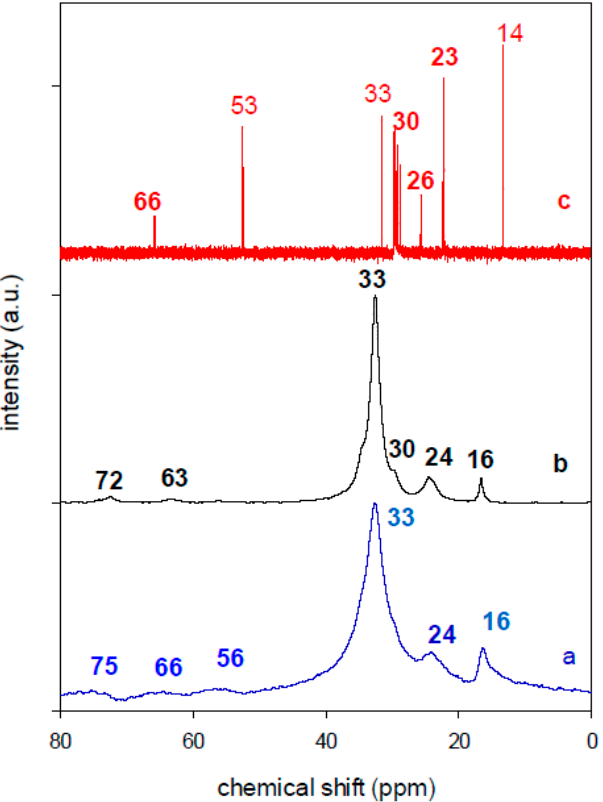
Figure 6. Solid 13 C-CP-NMR of the ( a ) organoclay C 16 Cl-CN, ( b ) the C 16 Br solid salt, and ( c ) C 16 Br Figure6. Solid 13 C-CP-NMRofthe( a )organoclayC 16 Cl-CN,( b )theC 16 Brsolidsalt, and( c )C 16 liquid.